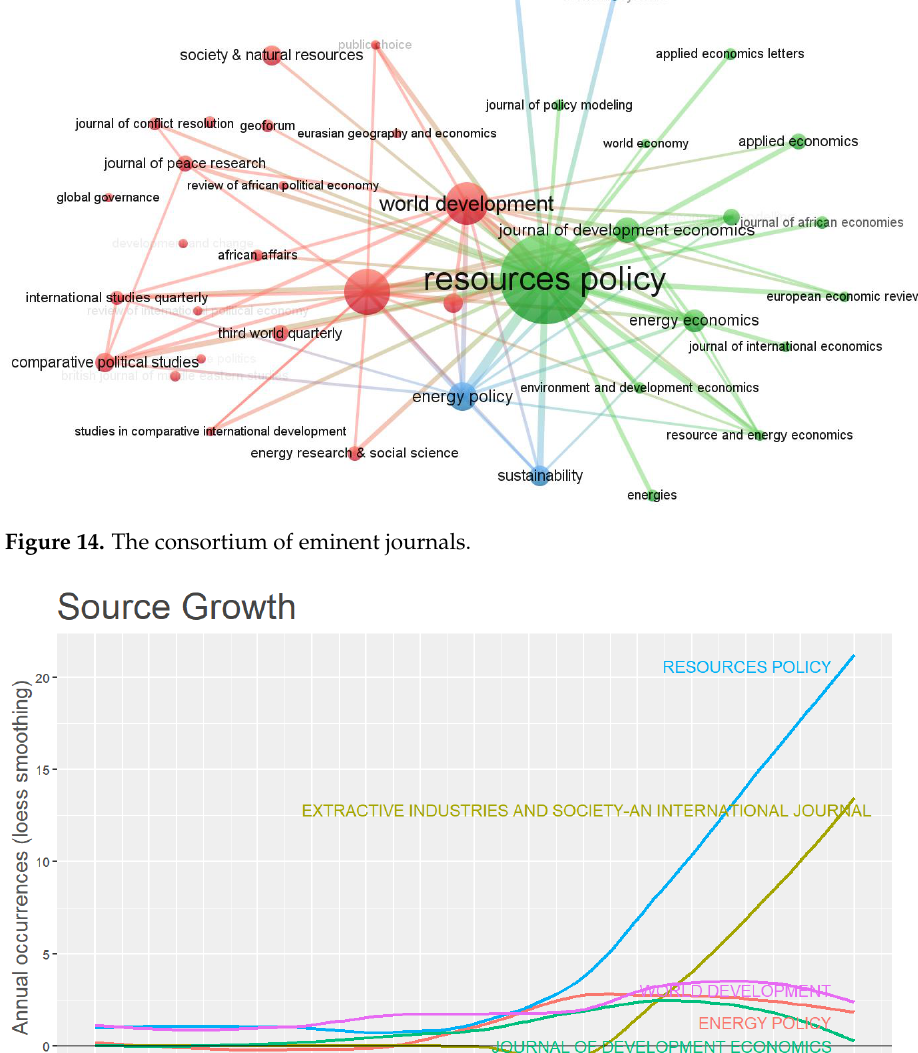
Figure 14. The consortium of eminent journals.